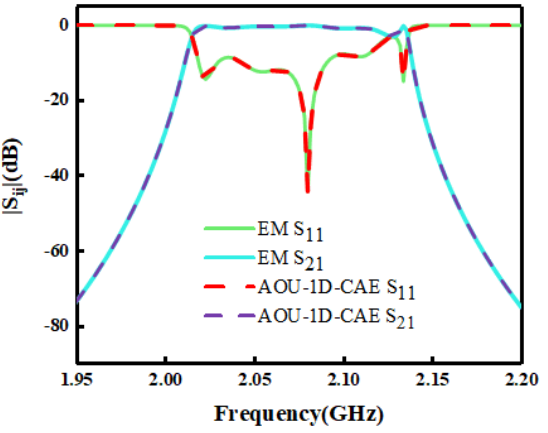
Figure 13. Eighth−order cavity filter HFSS simulation results with proxy model network prediction results.